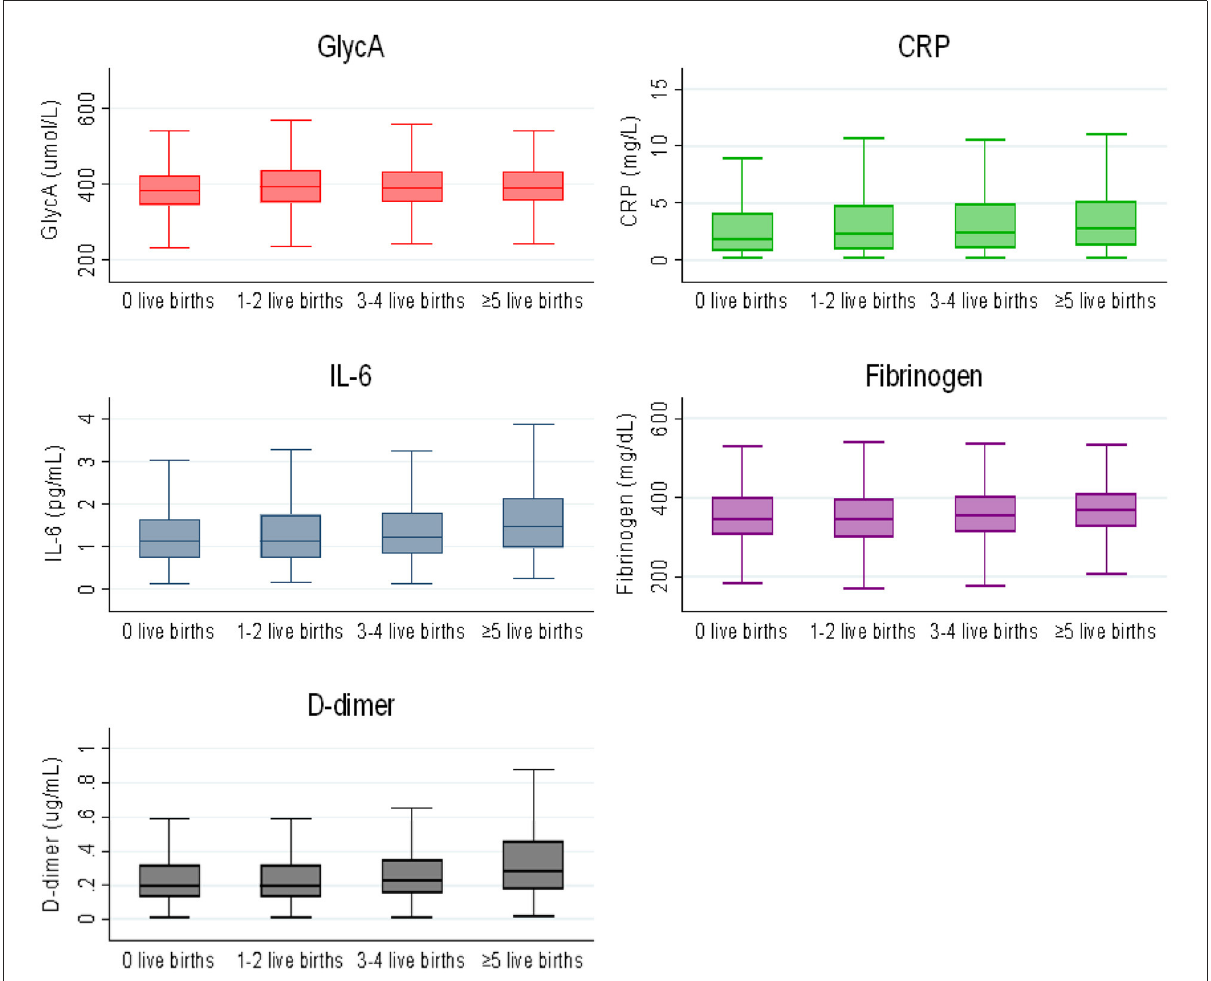
FIGURE1 Box plot of inflammatory markers by parity categories. The lower and upper boundaries of the rectangles denote the 25th and 75th percentiles while the horizontal line within the rectangles is the median. Lines extend from the rectangles to the smallest and largest values within 1.5 × interquartile